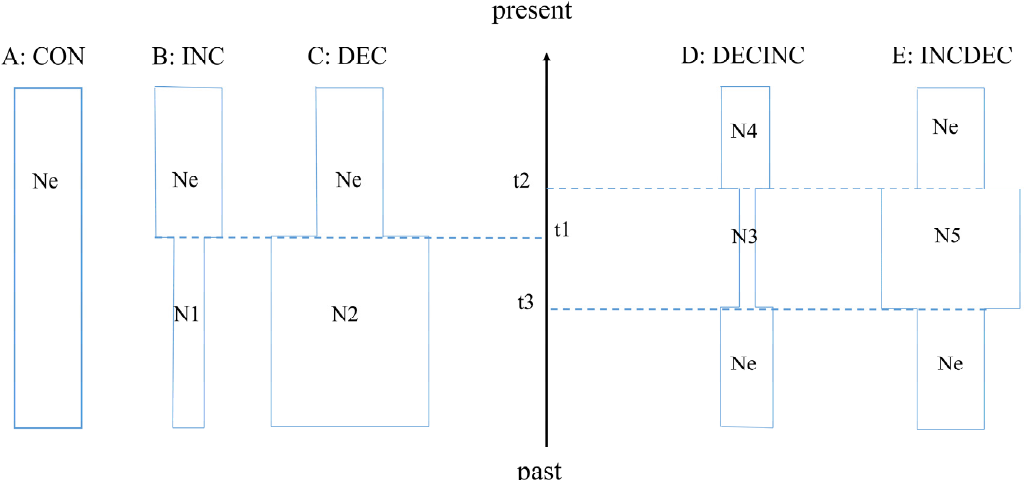
Figure 2. Schematic representation of five demographic scenarios for Epinephelus awoara tested by approximate Bayesian computation (ABC). Time and effective population size are not to scale. Graphical representation of the five scenarios: ( A ) scenario 1 (CON model); ( B ) scenario 2 (INC model); ( C ) scenario 3 (DEC model); ( D ) scenario 4 (DECINC model); ( E ) scenario 5 (INCDEC model).